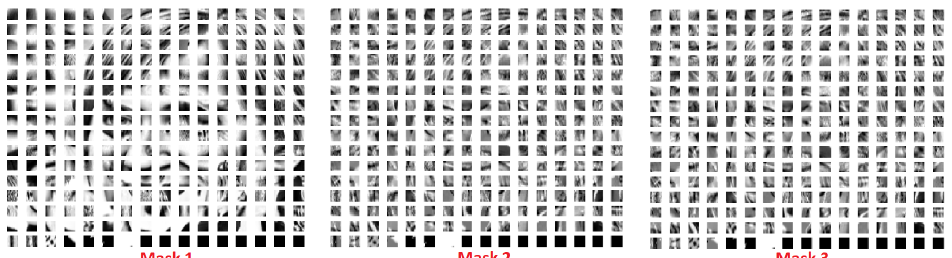
Figure 5. The three generated masks.